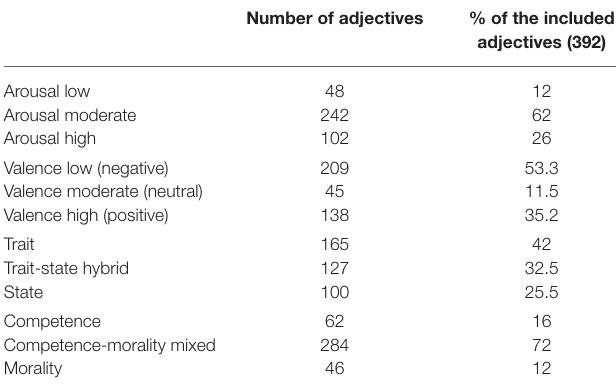
TABLE 2 | Numbers and percentages of the adjectives rated on every dimension (divided into low, moderate, and high or one category type or a mixed category based on the rating